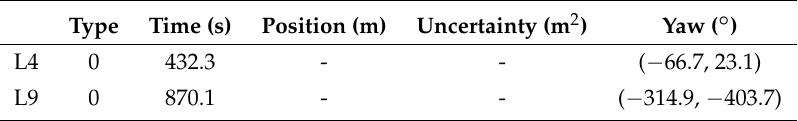
Table 2. Landmark